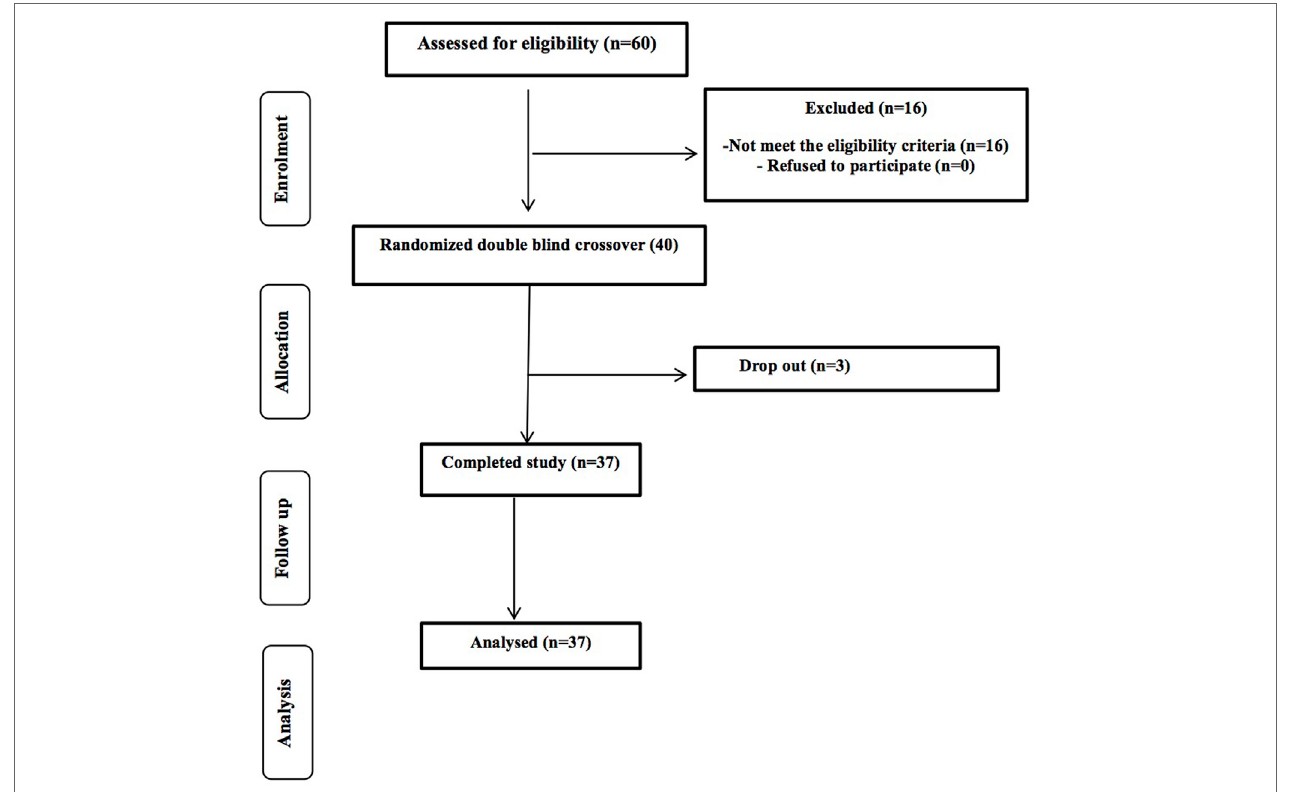
FiGUrE 1 | Flow of the study participants through the